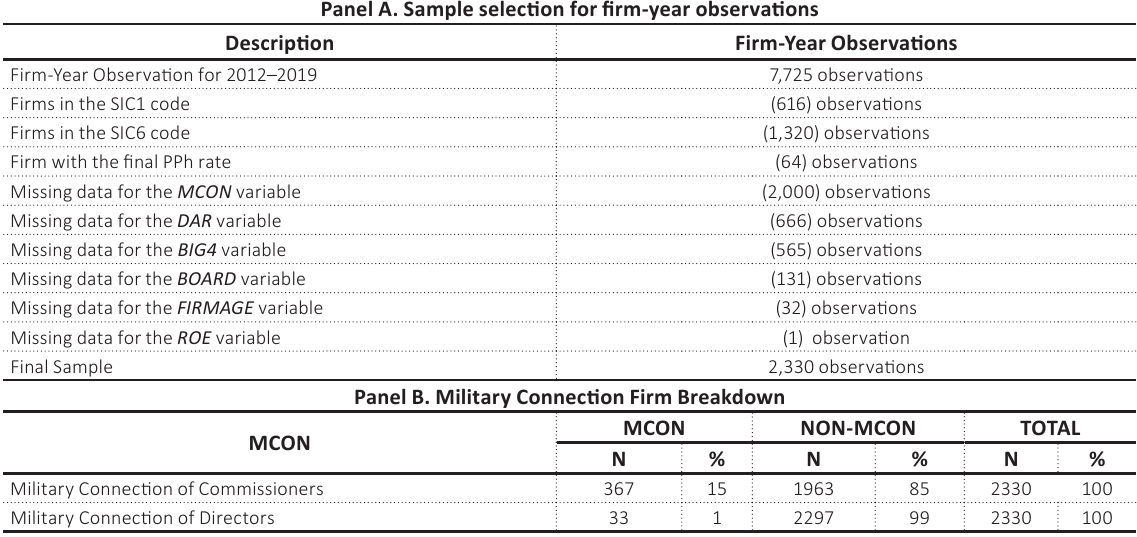
Table 1. Sample selection and breakdown Panel A. Sample selection for firm-year